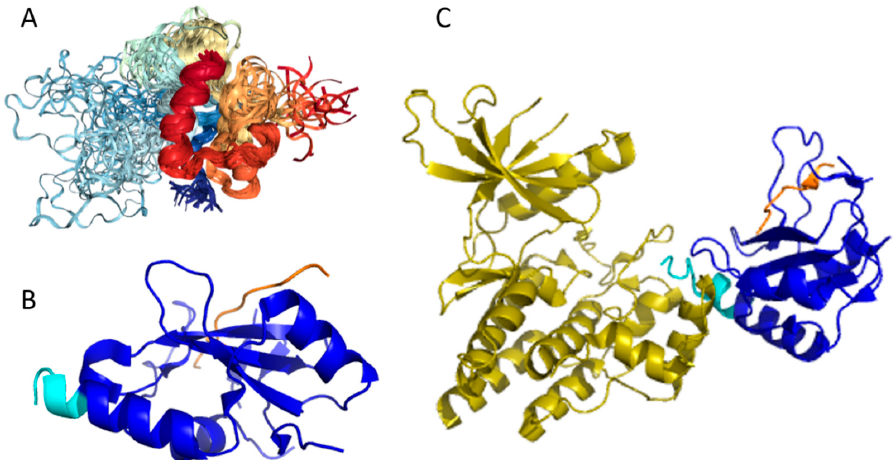
Figure 15. Structural characterization of murine suppressors of cytokine signaling 3 (SoCS3) protein. ( A ) Solution nuclear magnetic resonance (NMR) structure of the central region of murine SoCS3 (residues 22–161, blue-yellow structures) complexed with a phosphopeptide from the gp130 receptor (PDB ID: 2BBU, red-orange structures) [172]. ( B ) Crystal structure of the same region of murine SoCS3 protein (blue-cyan structure) complexed with gp130 (pTyr757) phosphopeptide (orange chain) (PDB ID: 2HMH) [172,173]. ( C ) Crystal structure of a ternary complex between the murine SoCS3 (residues 29–162, blue-cyan structure), protein kinase domain 2 of JAK2 (residues 835–1126, yellow structure), and a fragment of the interleuikin-6 (IL6) receptor β -chain (residues 749–763, orange chain) (PDB ID: 4GL9)